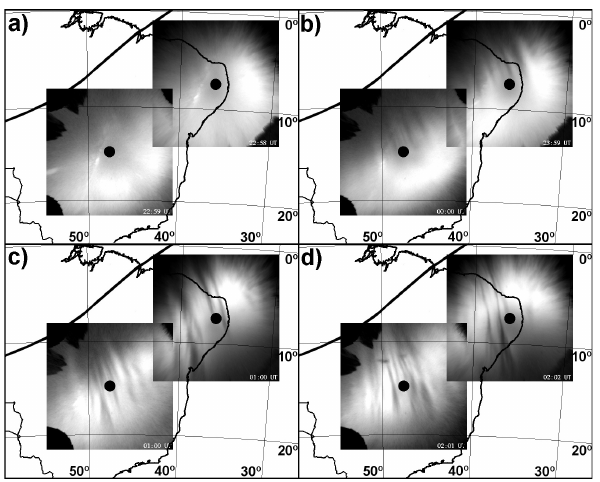
Fig. 7. Evolution of the bubbles structures observed simultaneously from Brasilia and Cariri during the following night (1–2 October) over the same time interval as Fig. 6. Note the lack of structure above Brasilia during the first two hours (panels a and b